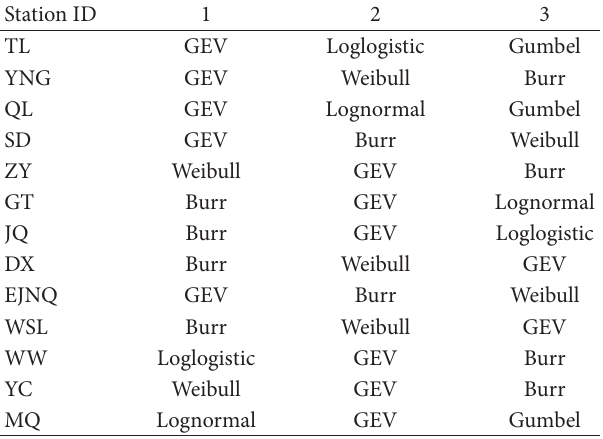
maximum datasets as well. Results of K-S test are shown in Figure 4. The legends are the same as those in Figure 2 and thus omitted. As annual ones, Exponential and Pareto